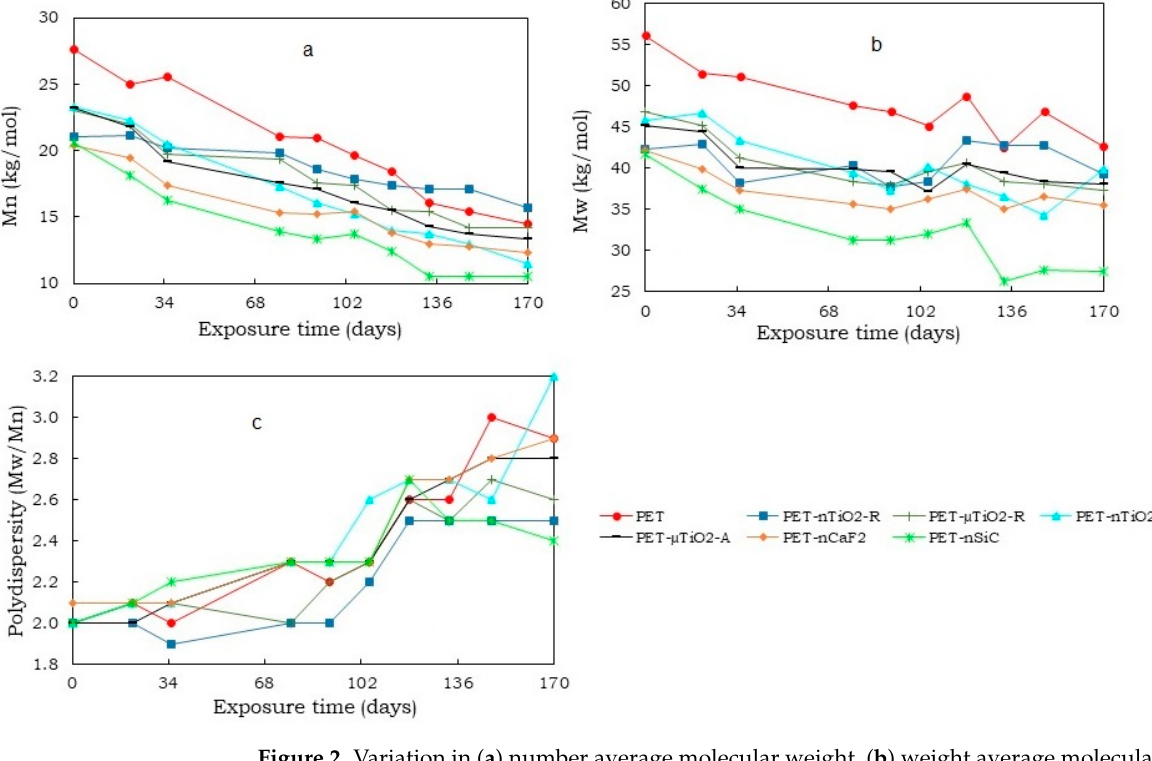
Figure 2. Variation in ( a ) number average molecular weight, ( b ) weight average molecular weight, and ( c ) polydispersity of yarns at different exposure times.